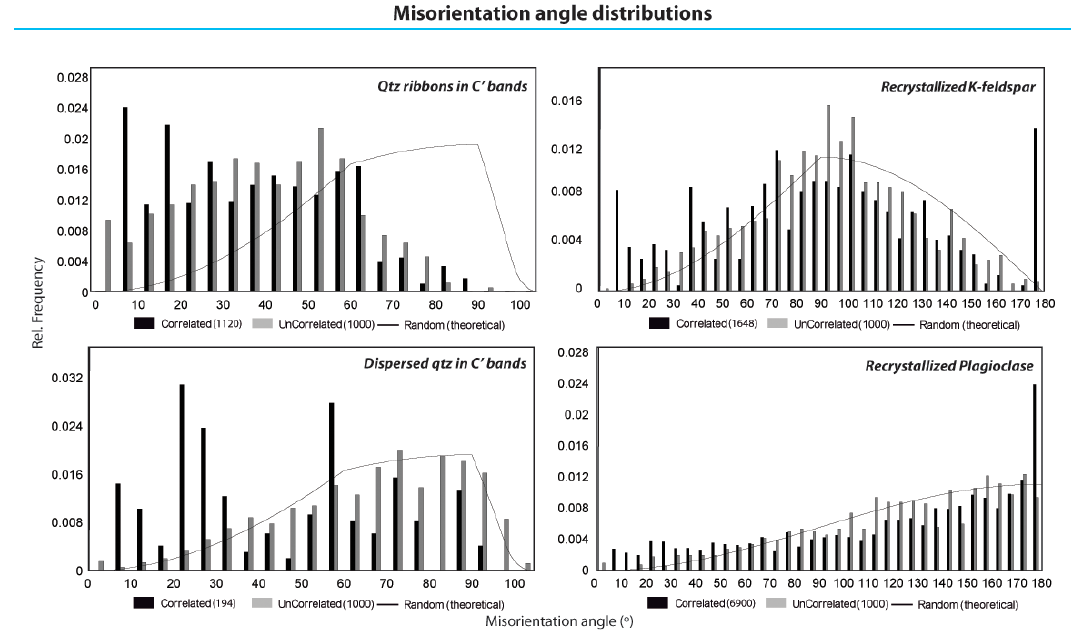
Figure 14. Misorientation angle distributions for the phases within the C’ band shown in Fig. 13. See text for